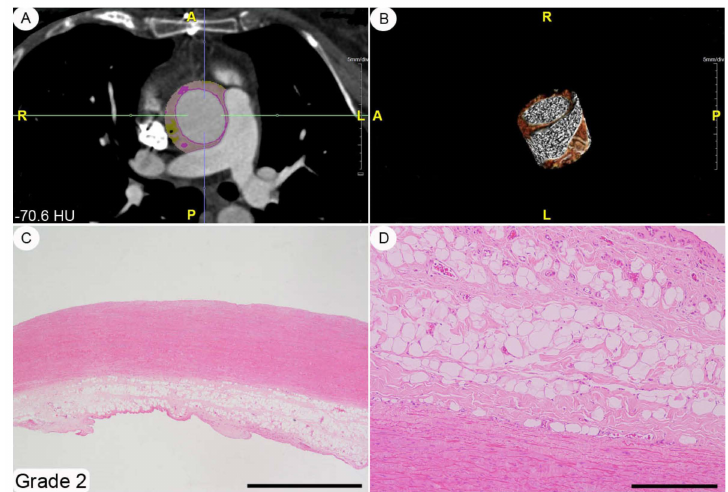
Figure 3. Adventitial fibrosis, grade 2. This index case refers to a 69-year-old male patient with AA aneurysm on CTA, an attenuation histogram of peri-vascular adipose tissue of mean − 70.6 HU ( A , B ). The corresponding histopathology displays a mild-to-moderate increase in tunica media thick- ness ( C ) and a moderate replacement of the adventitial/periadventitial soft tissues by collagen fibers ( D ) with more obvious aspects of adipocyte hypotrophy/atrophy as in Grade 1 ( D ). Staining.